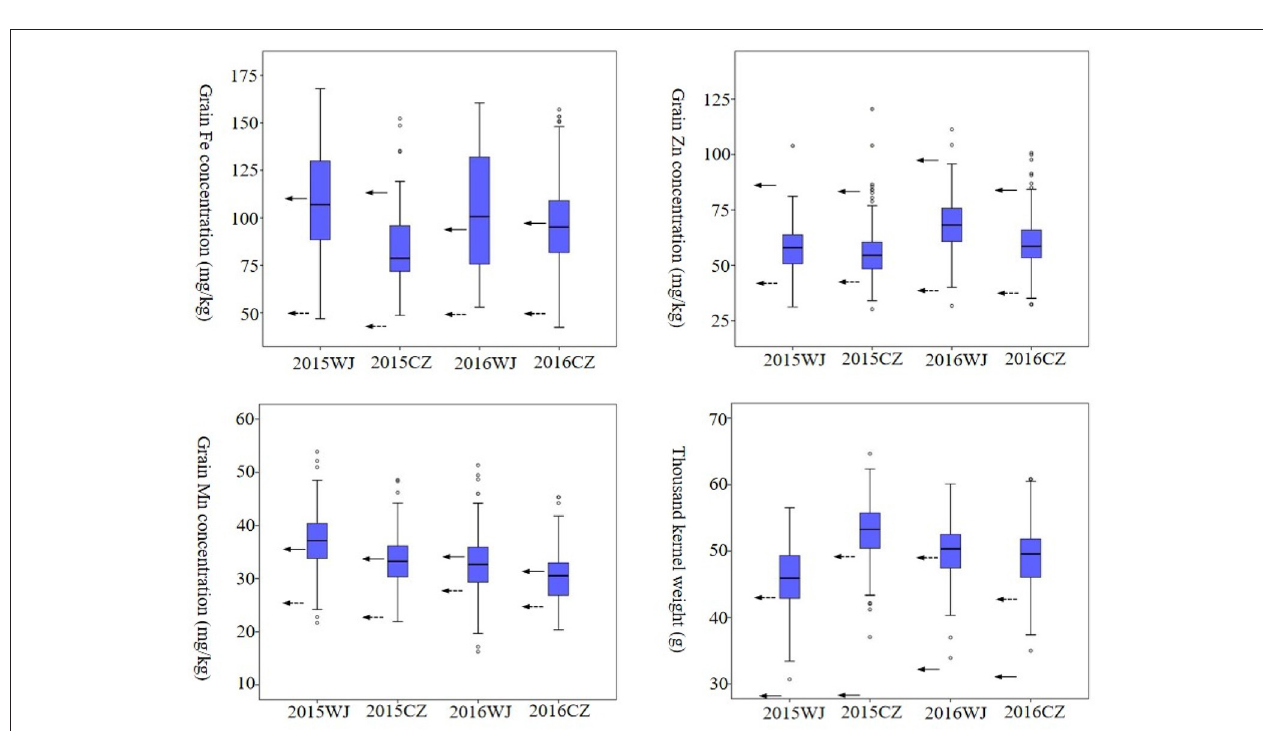
FIGURE 2 | Frequency distribution of GFeC, GZnC, GMnC, and TKW under four environments in the advanced lines. Solid arrows represent the values of D1. Dashed arrows represent the values of CN16.